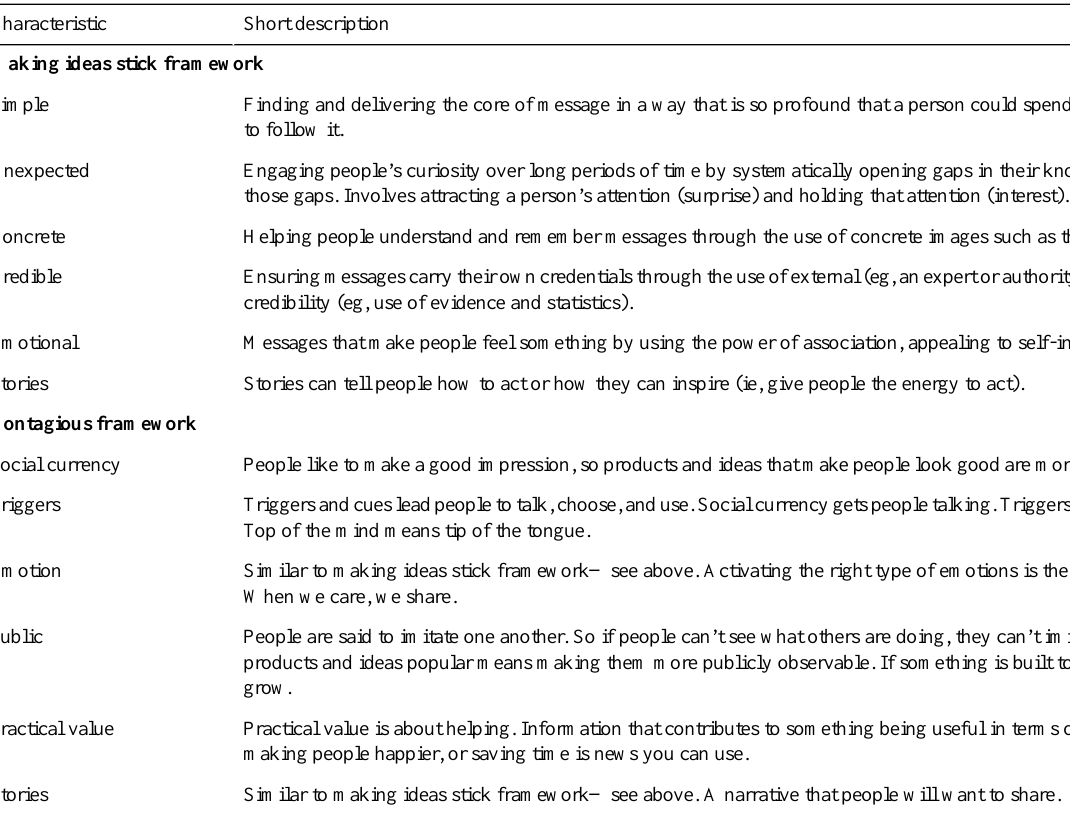
Table 1. List of stickiness